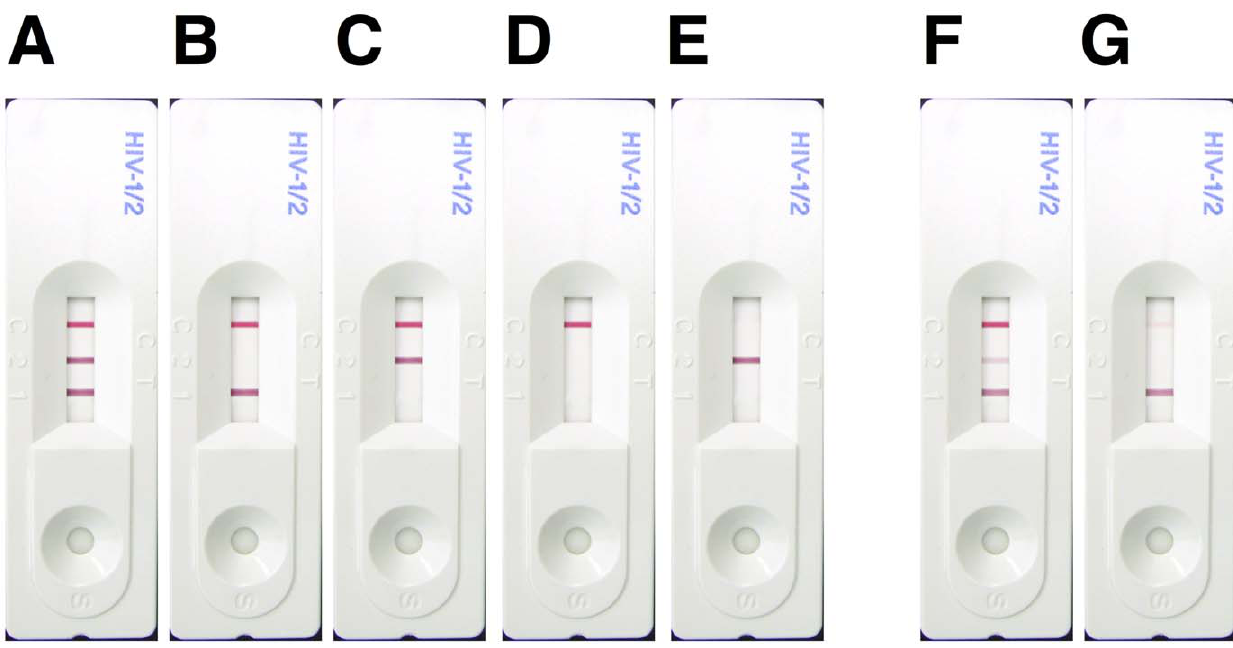
Figure 4. Possible results for the three-line SD Bioline HIV rapid diagnostic test (RDT) that presents indicator lines for control, HIV-2 and HIV-1. HIV-1/2 positive (A), HIV-1 positive results (B, F & G), HIV-2 positive (C), HIV negative (D) and Invalid (E) results. A-E were considered "obvious" because the manufacturers’ instruction illustrated these types of result. F & G are both HIV-1 positive and considered "difficult" because the correct interpretation required comparison of intensities for the middle and bottom lines (F), or the ability to see and interpret a faint line (top line, G).